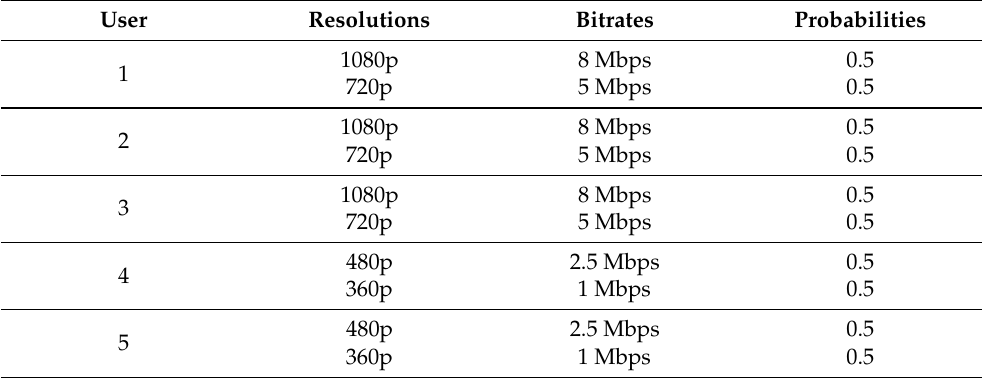
Table 2. Simulated user